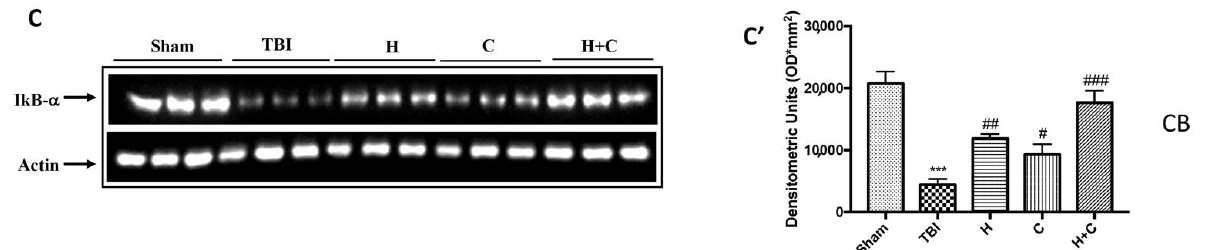
Figure 6. Effect of H. erinaceus or C. versicolor , or H. erinaceus + C. versicolor treatment on IκB-α protein after chronic TBI. Western blot analysis showed that the expression of IκB-α decreased insignificantly in the TBI group in CX ( A ), HP ( B ) and CB ( C ) regions. H, C, and H + C treatment further significantly increased the expression of IκB-α ( A – C ). The data are expressed as the mean SEM from n = 5 mice/group. Densitometry analysis: ( A’ ) *** p < 0.001 vs. Sham; ## p < 0.01 vs. TBI; # p < 0.05 vs. TBI; ### p < 0.001 vs. TBI; ( B’ ) *** p < 0.001 vs. Sham; ## p < 0.01 vs. TBI; # p < 0.05 vs. TBI; ### p < 0.001 vs. TBI;